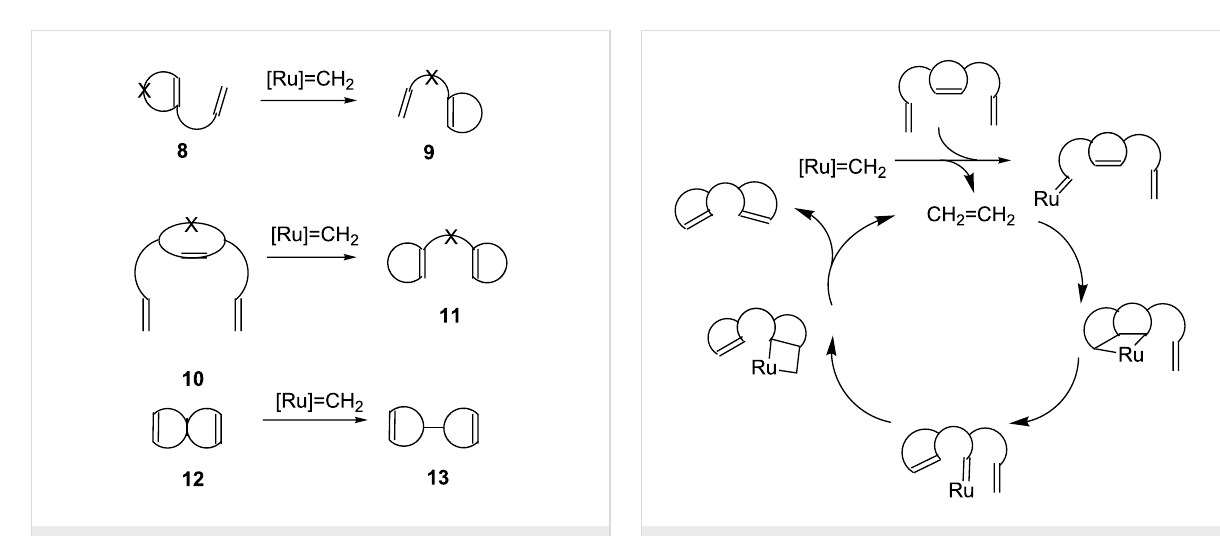
Figure 2: General representation of various RRM processes. Figure 3: A general mechanism for RRM